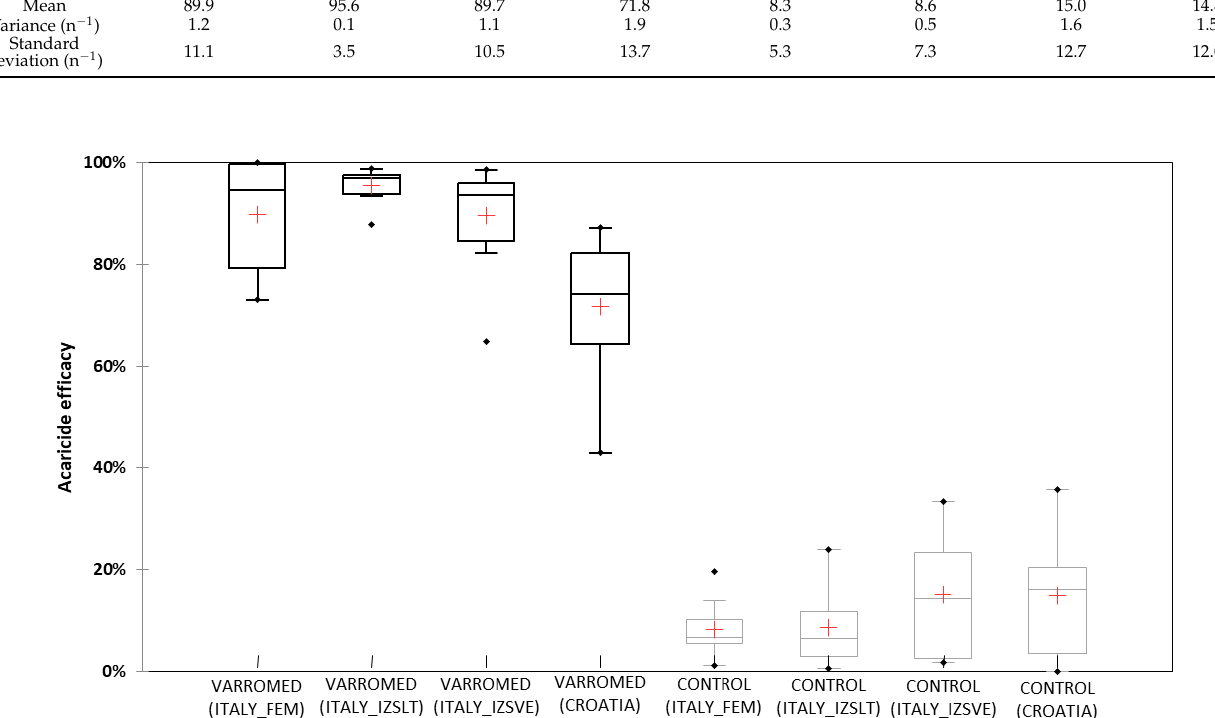
Figure 7. Box plot of acaricide efficacies recorded during the winter trial and relative mite fall during the same period in the control group (%). The horizontal line in boxes shows the median. The box shows the first and third quartile. Whiskers extend to 1.5 × interquartile range (IQR). Additionally, the pluses show mean values. Small variations of coverage of adult honey bees were recorded but no statistically significant differences were observed (Table 6; Figure 8). No queen mortality and no clinical signs of other economically important diseases were observed. Table 6. Variation of adult honey bee coverage in all groups recorded during the winter trial compared to the beginning of the treatment